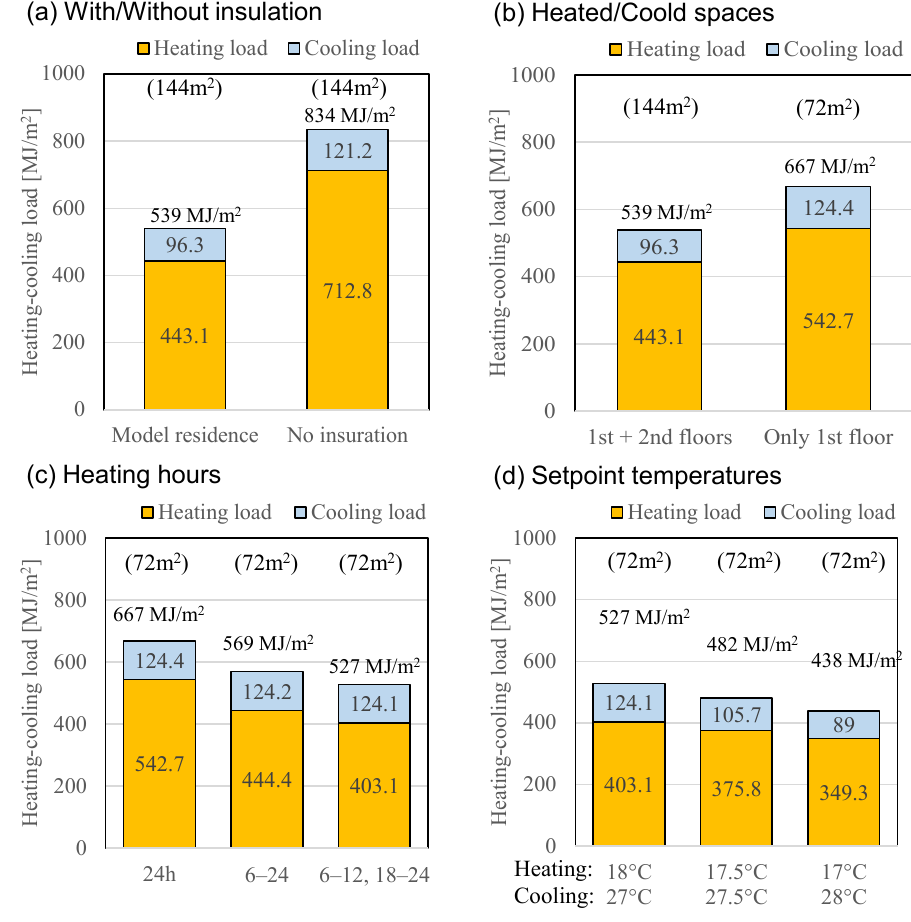
Figure 11. Calculated results of annual heating/cooling load.